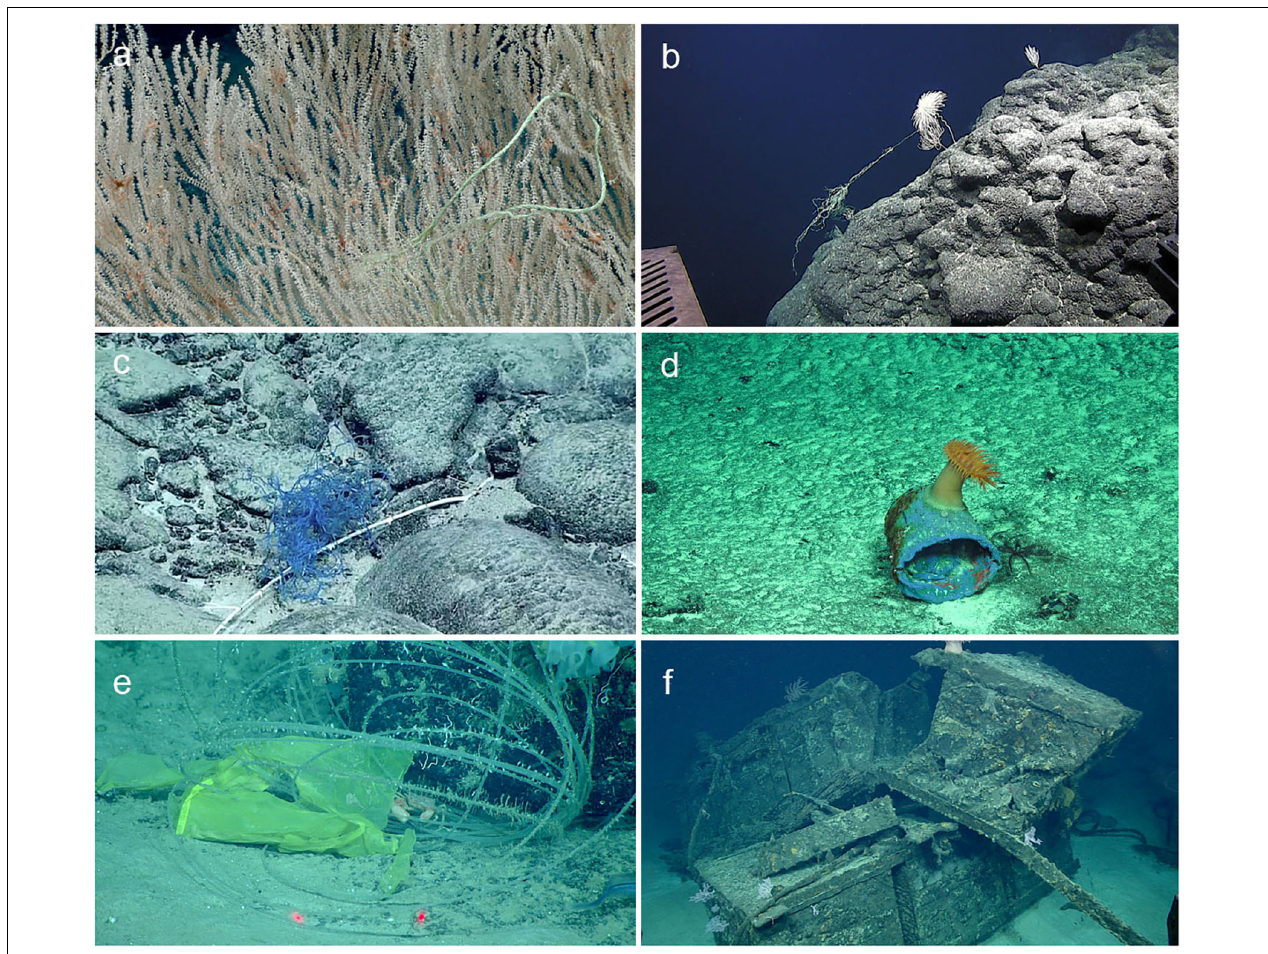
FIGURE 6 | Biological interactions with deep-sea debris. (a) Fishing line entangled in a large primnoid coral at 1,772 m in the Musician Seamounts in ABNJ. (b) Fishing line entangled in a primnoid coral at 1,167 m in the northwestern Hawaiian Islands. (c) The skeleton of an isidid coral entangled in fishing line at 2,005 m on Pigafetta Guyot off the Mariana Islands. This may have contributed to its death. (d) A plastic bucket providing substrate for an actiniarian at 1,025 m in the PIPA. (e) A plastic bag and fishing line providing shelter for a crab and substrate for cirripeds at 791 m at CAIMAN/I-203 off the main Hawaiian Islands. (f) A metal dock from World War II intentionally sunk at 784 m off the main Hawaiian Islands and now providing shelter and substrate for a variety of species including multiple octocorals, crabs, squat lobsters, sponges, barnacles, and anemones. The central red lasers points indicate 10 cm scale in